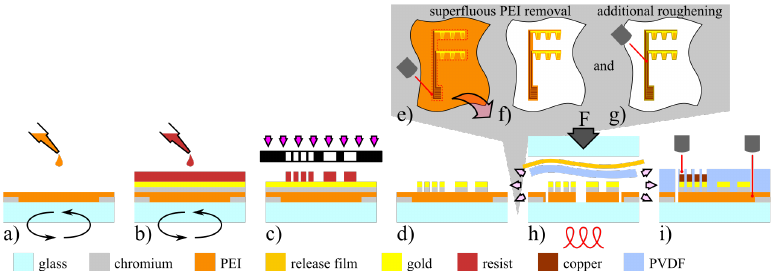
Figure 1. Smart inlay fabrication: ( a ) PEI spin coating; ( b , c ) metallic layer sputtering and lithography; ( d ) chemical wet etching; ( e ) PEI cutting; ( f ) superfluous PEI foil peel off; ( g ) roughening by means of fs-laser ablation; ( h ) PVDF encapsulation; ( i ) geometry cut and pad